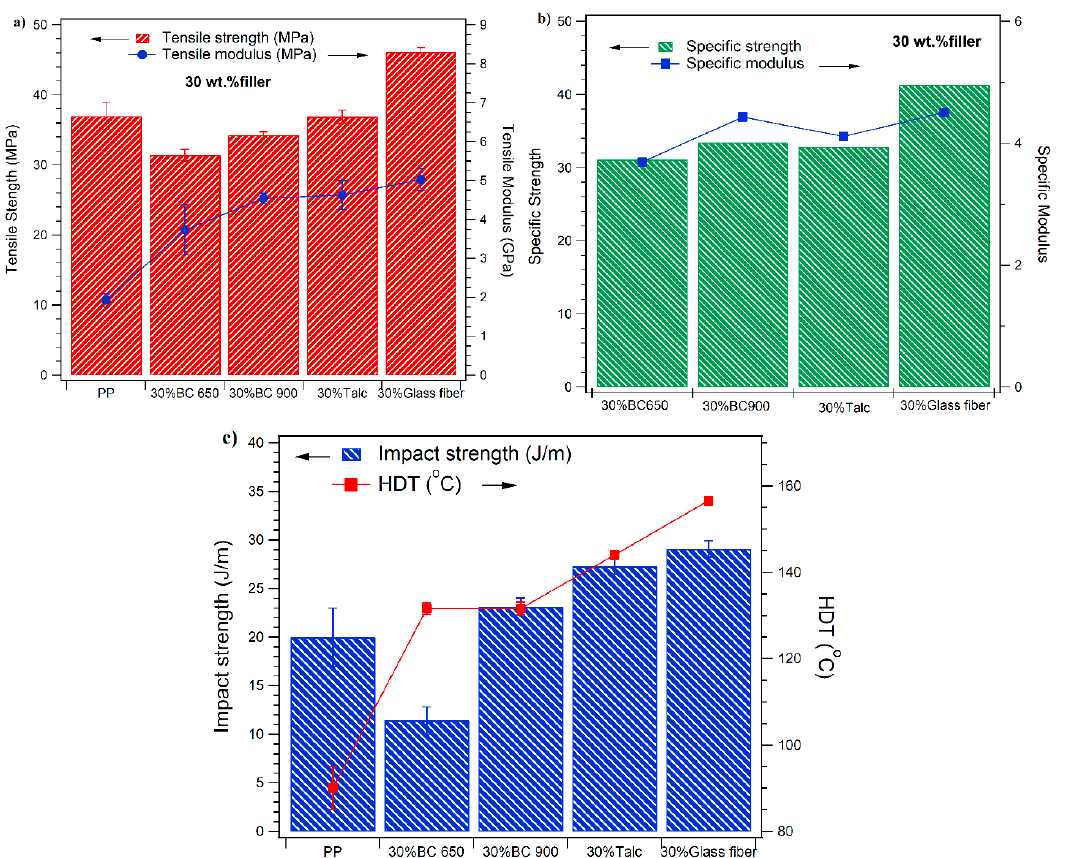
Figure 7. Mechanical and HDT properties of neat PP and PP with 30 wt.% filler: ( a ) tensile and modulus strength, ( b ) specific strength and modulus, and ( c ) impact strength and HDT.